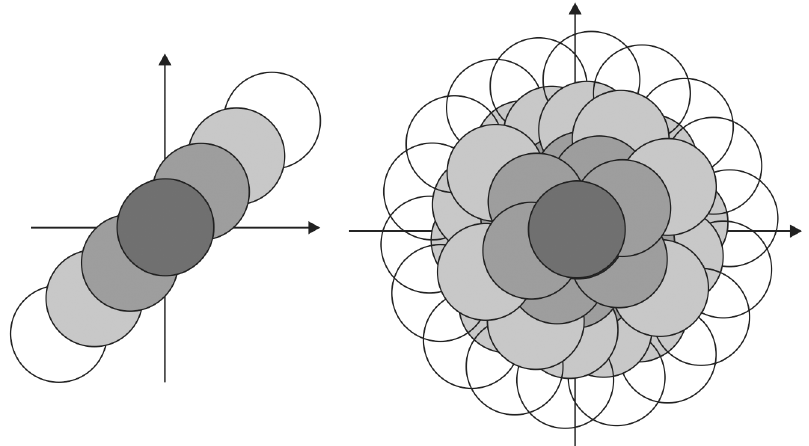
Fig. 4. The OTF extension by nonlinear structured illumination. 11